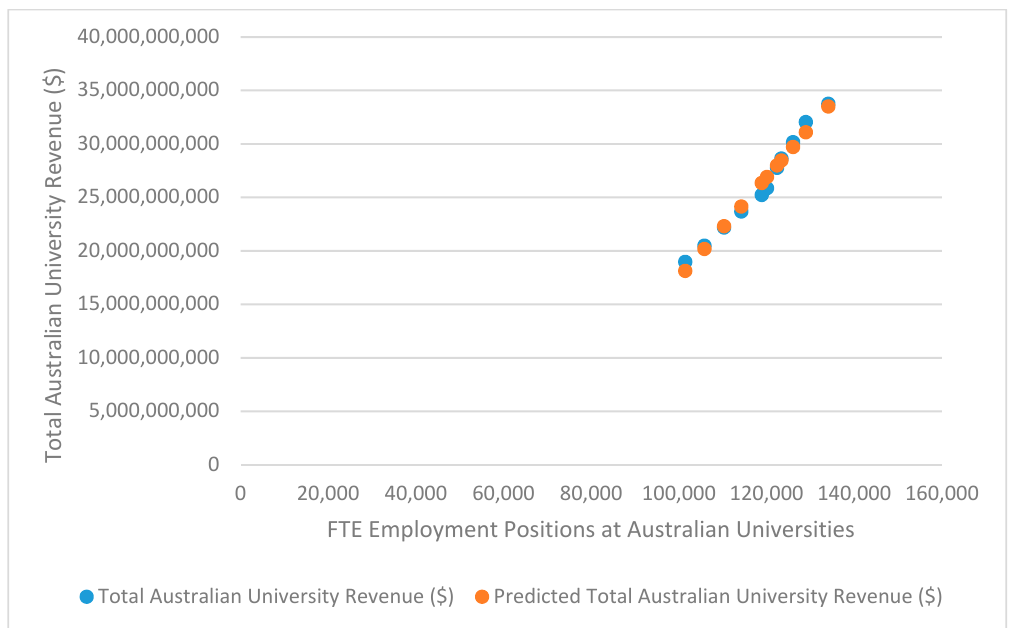
Figure 4. Line Fit Plot for International Student Enrolments and Total Australian University Revenue.